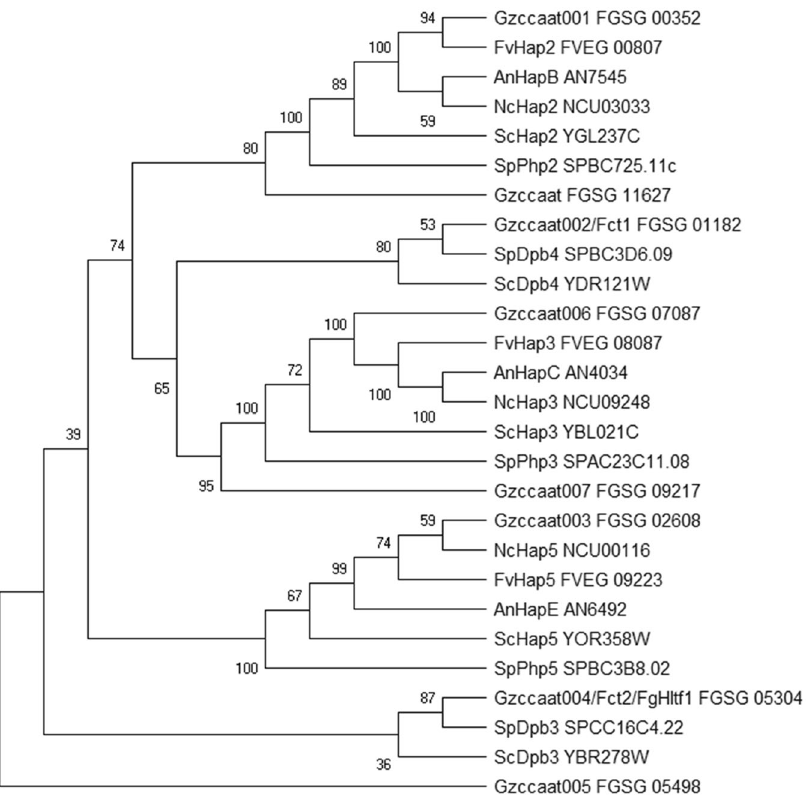
Figure 2. Phylogenetic tree of fungal CCAAT-binding factors. The alignment was performed with ClustalW, and MEGA X was used to perform a 1,000-bootstrap phylogenetic analysis using the neighbour joining method 62 . Bootstrap support is shown for each